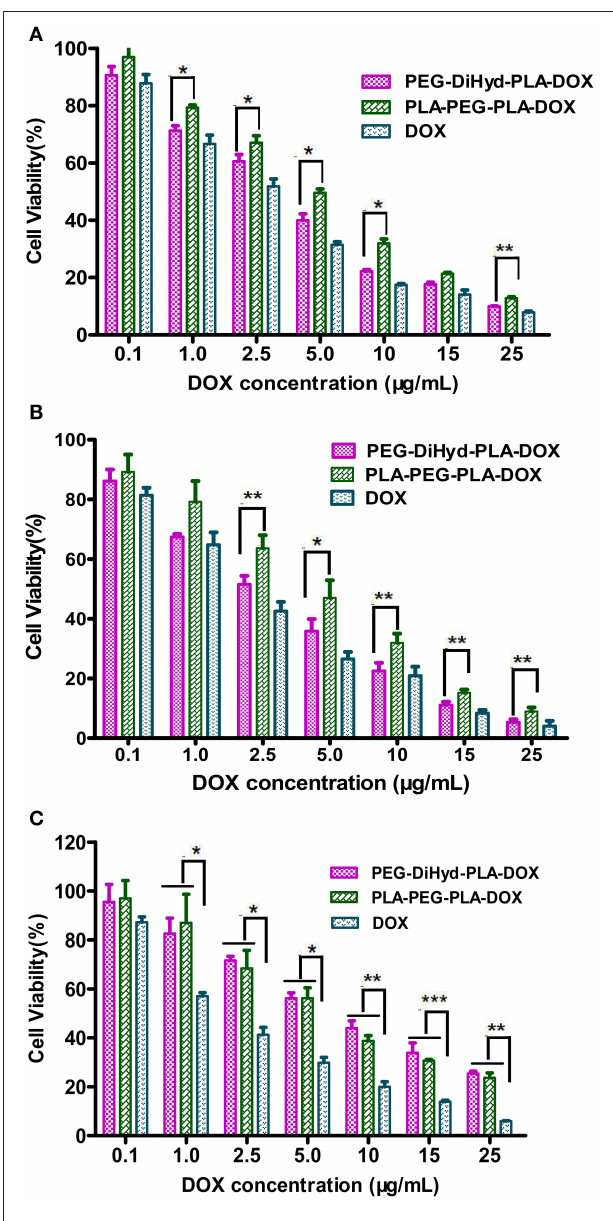
FIGURE 8 | The cytotoxicity of DOX loaded PLA-PEG-PLA-18K, PEG-DiHyd-PLA-18K micelles and Free DOX incubated with HepG-2 cells (A) , MCF-7 cells (B) , and L-02 (C) at different DOX concentrations 48h. Data were presented as mean ± standard deviation ( n = 3) (* p < 0.05, ** p < 0.01, *** p < 0.001).